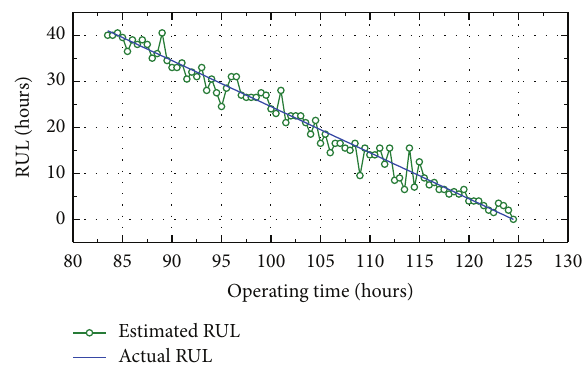
Figure 17: RUL estimation for the outer-race-fault case based on original signal similarity.